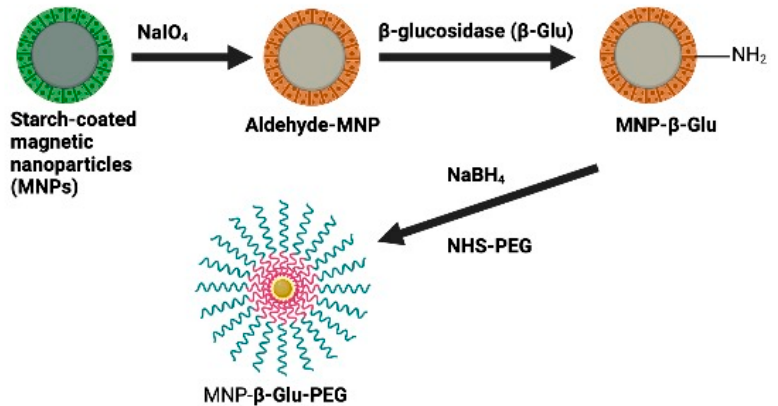
Figure 7. Schematic diagram of preparation process of MNP ‐β‐ Glu ‐ PEG.